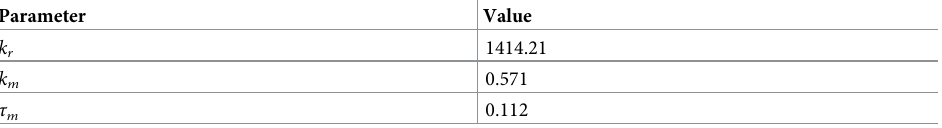
Initial parameter values for the enhanced bout generator found by minimizing the bout rate prediction error with the intensity scale factor fixed for each experimental condition at the value that yields the observed mean bout